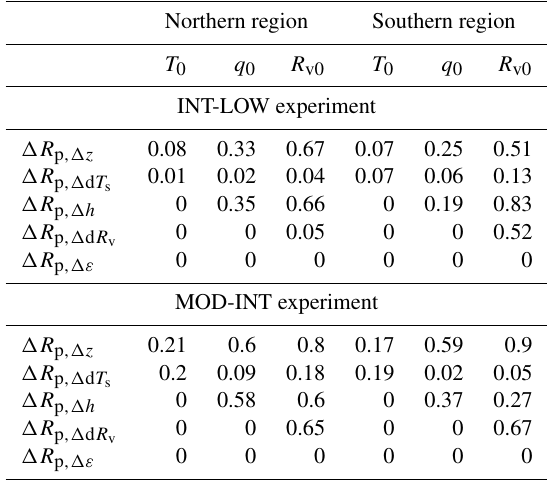
Table 3. Values of isotopic changes due to decomposed terms for two uplift stages and for two regions (see the text).